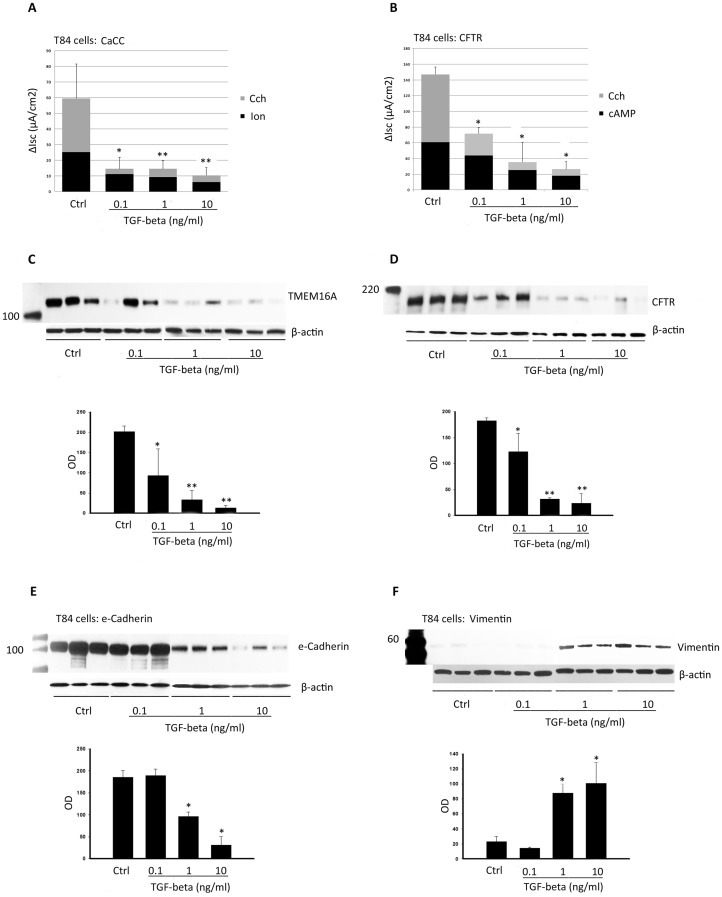
Dose-response effects of TGF-beta on TMEM16A, CFTR, e-cadherin, and vimentin in T84 cells.T84 cells were treated with TGF-beta (vehicle control, 0.1, 1.0, and10 ng/ml) for 48 h, followed by Ussing chamber and immunoblot as described in Methods. (A and B) CaCC (*P<0.003, **P<0.01) and CFTR (*P<0.0001) currents were reduced by TGF-beta treatment at every dose used. (C and D) TMEM16A (*P<0.01, **P<0.005) and CFTR (*P<0.05, **P<0.0001) expression was suppressed by TGF-beta treatment at every dose used. E-cadherin expression (E) was decreased (*P<0.011) and vimentin expression (F) was increased (*P<0.05) with 1 ng/ml or greater TGF-beta treatment.